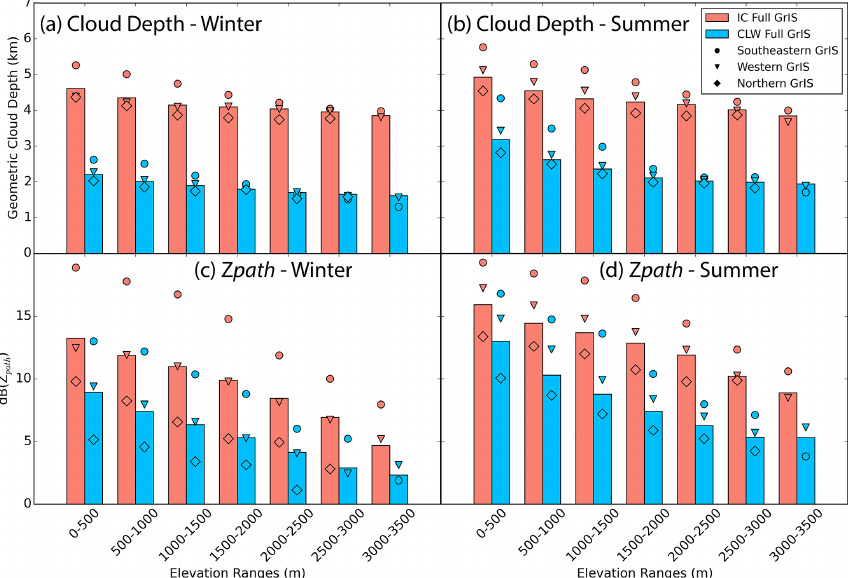
Figure 9. Geometric cloud depth partitioned by elevation for (a) winter (October–April) and for (b) summer (May–September). Column- integrated CPR reflectivity within the cloud layer (dB (Z path ) ) for (c) winter and (d) summer. The red bars are the mean value at each elevation for all IC events across the full GrIS for the given season and elevation. The blue bars are the means for the CLW events. The symbols represent the means for three GrIS regions: the southeastern GrIS (filled circles, basins 3.3, 4.1, 4.2, 4.3, and 5.0 in Fig. 1), the western GrIS (filled triangles, basins 6.1, 6.2, 7.1, 7.2, 8.1, and 8.2), and the northern GrIS (filled diamonds, basins 1.1, 1.2, 1.3, and 1.4).